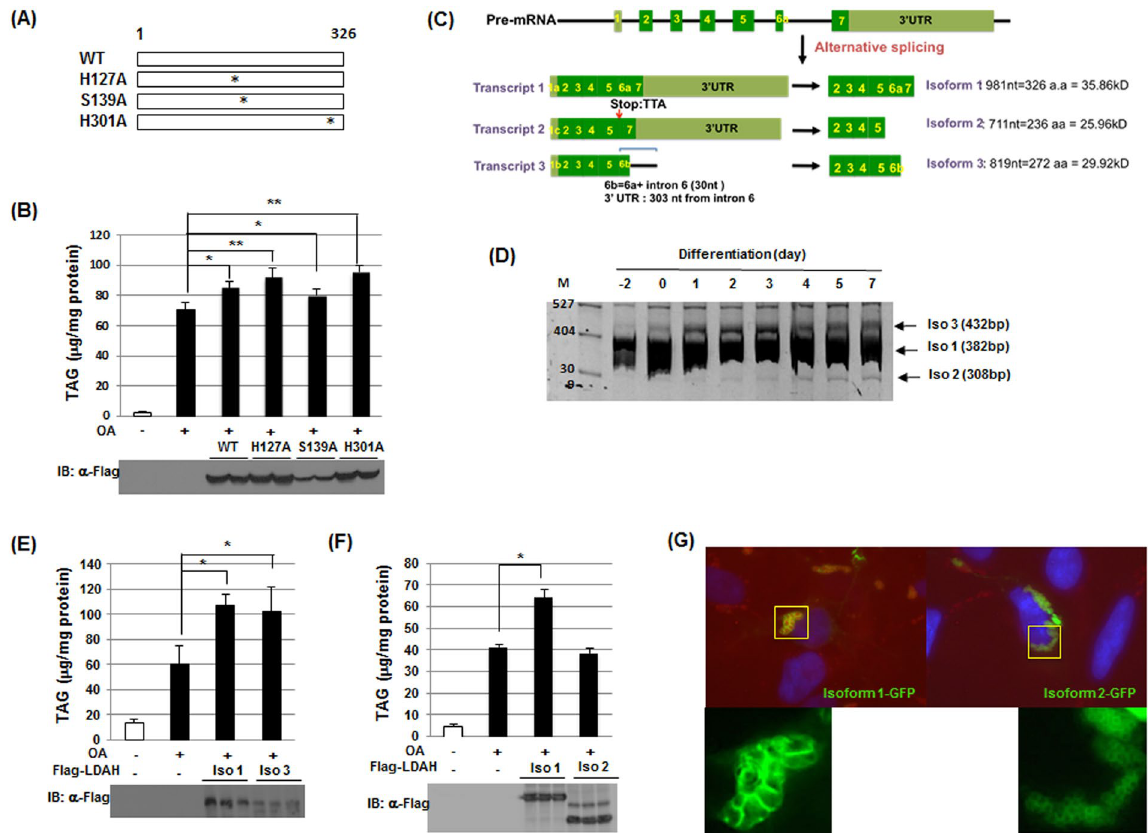
Figure 4. LDAH’s role in LD growth and TAG accumulation is related to its C-terminal region rather than to its catalytic sites. ( A ) Diagrams of point mutants of full-length LDAH used in the studies, including mutations of hystidine to alanine in predicted acyltransferase motifs, and of serine to alanine in the predicted hydrolytic motif. ( B ) TAG levels (top) and immunoblotting with anti-Flag antibody (bottom) in HEK293 cells overexpressing Flag-wild type or Flag-mutant LDAH, and loaded with OA (360 μ M) for 24 h. * p < 0.05, ** p < 0.005. ( C ) Diagram of predicted LDAH splicing variants. ( D ) mRNA expression of LDAH isoforms 1, 2, and 3 during 3T3L1 differentiation. ( E ) TAG levels in Flag-tagged LDAH isoform 1 and isoform 3 overexpressing cells stimulated with OA (360 μ M) for 24 h. * p < 0.05. ( F ) TAG levels in Flag-tagged isoform 1 and isoform 2 overexpressing cells treated with OA (360 μ M) for 24 h. * p < 0.05. Immunoblottings (bottom) were performed using a anti-Flag antibody. ( G ) LDAH isoform 1-GFP and LDAH isoform 2 -GFP were transfected to HEK293 cells. After 24 h cells were treated with OA (360 μ M) for 24 h. LDAH was visualized by fluorescence microscopy (green) and LDs were stained with LipidTox